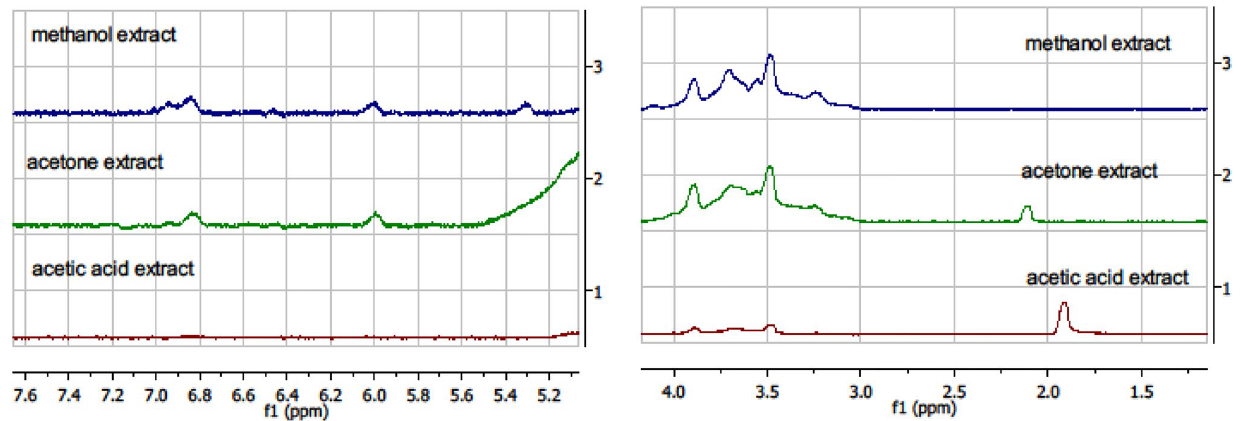
Fig. 2 1 H NMR spectra of Acacia rigidula’s acetone, methanol, and acetic acid extracts in deuterated water (D